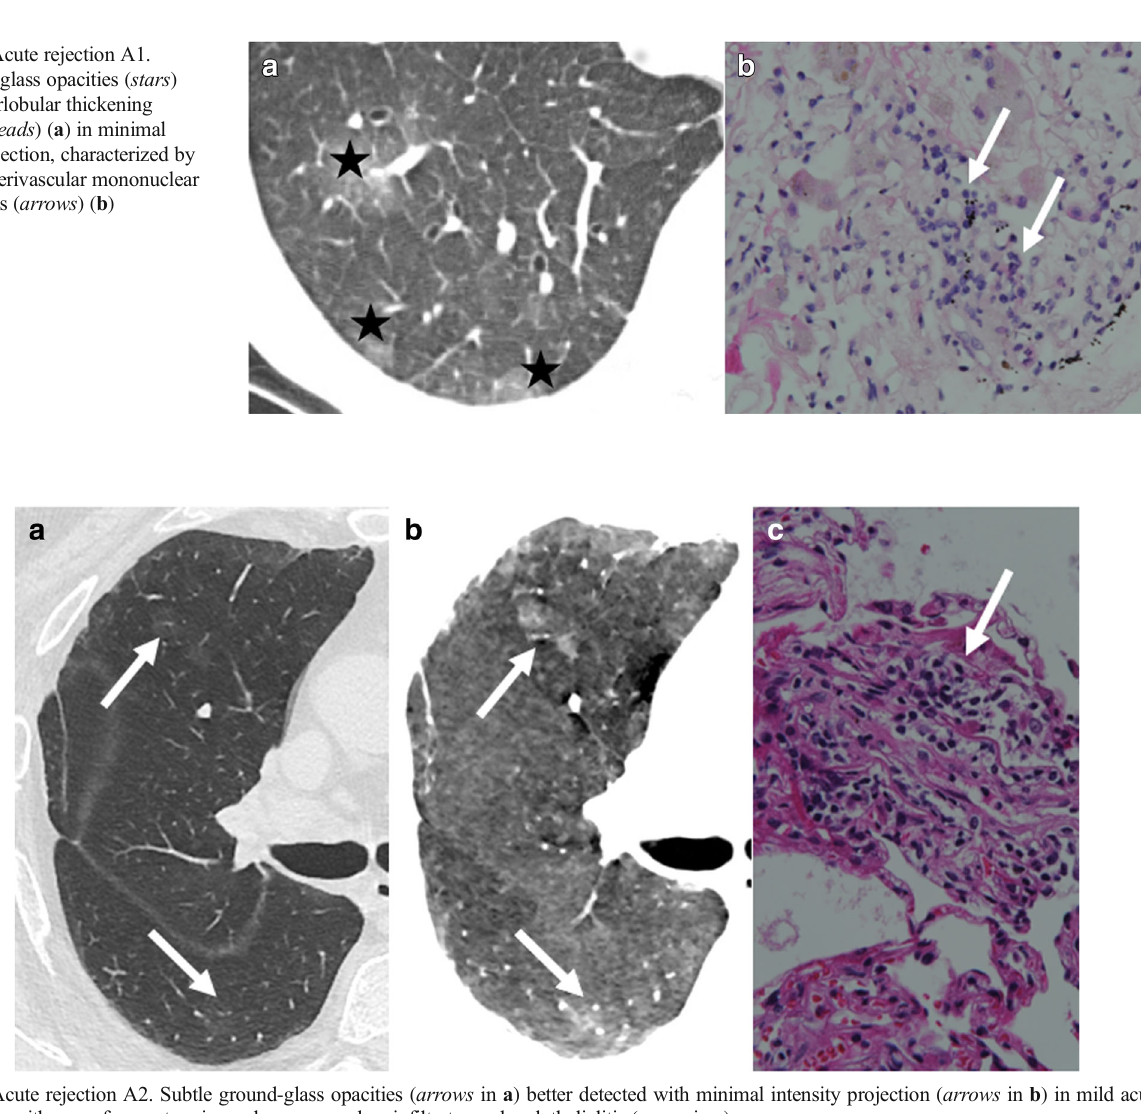
Fig. 8 Acute rejection A2. Subtle ground-glass opacities ( arrows in a ) better detected with minimal intensity projection ( arrows in b ) in mild acute rejection, with more frequent perivascular mononuclear infiltrates and endothelialitis ( arrow in c )